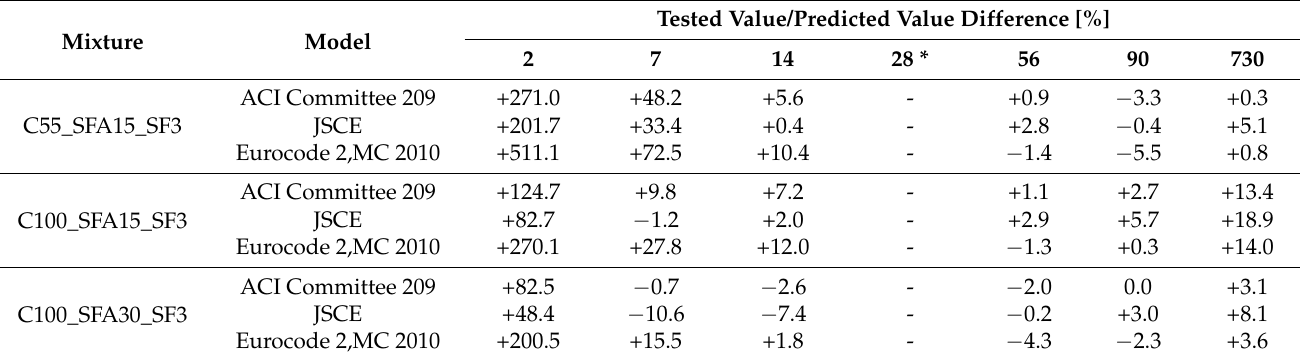
Table 6. Differences between tested and model-predicted compressive strength values. Mixture